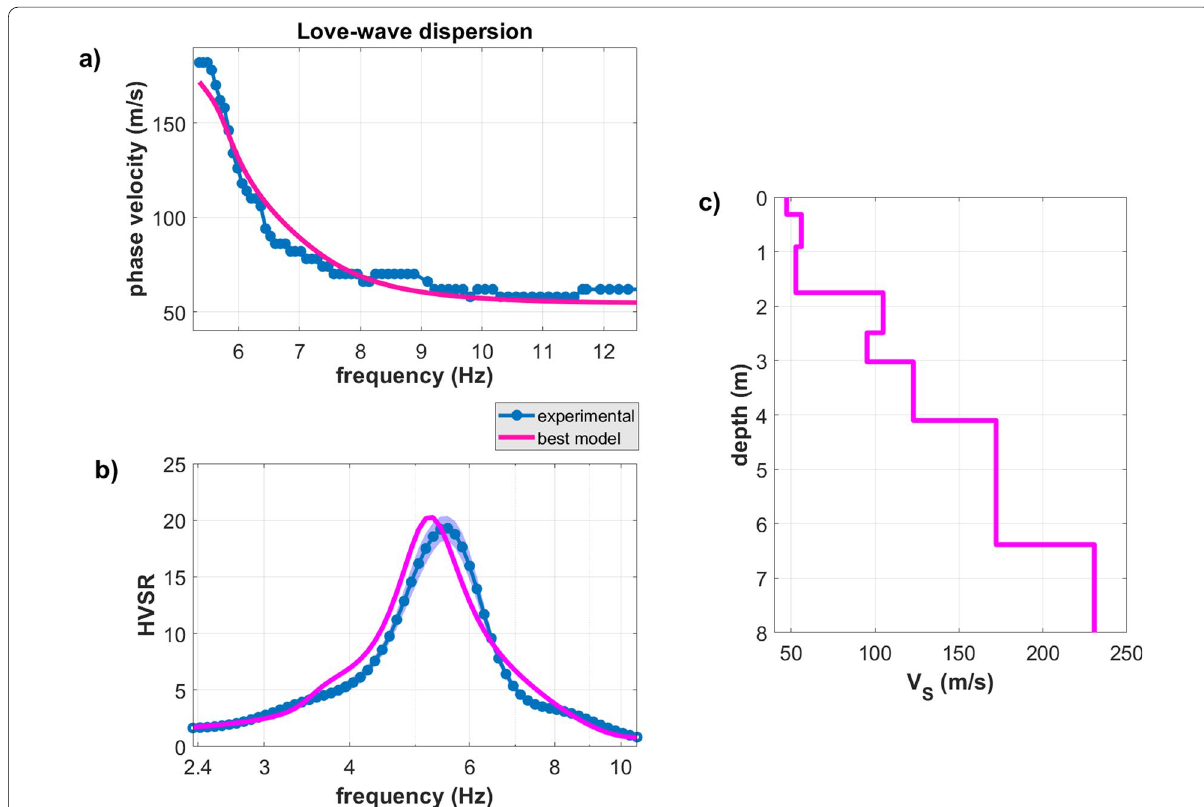
Fig. 22 Inline position 110 m (see Fig. 20c) : joint analysis of the HVSR and Love-wave dispersion curves (phase velocities). Shown the observed (blue) and inverted (magenta) curves for the Love-wave dispersion curve ( a ) and the HVSR ( b ). The V S model ( c ) represents the minimum-distance solution (i.e., the best model according to the adopted multi-objective inversion scheme) and clearly indicates the presence of a shallow 2 m-thick peat cover responsible for the low Love-wave velocities at frequencies higher than about 7 Hz and the large HVSR peak at about 5.7